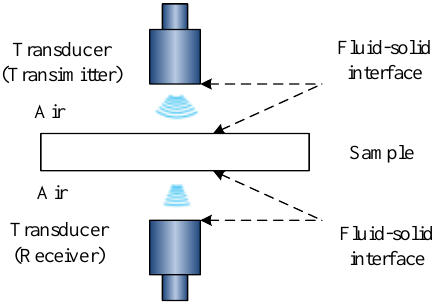
Figure 1. The schematic diagram of an ultrasound transmission.